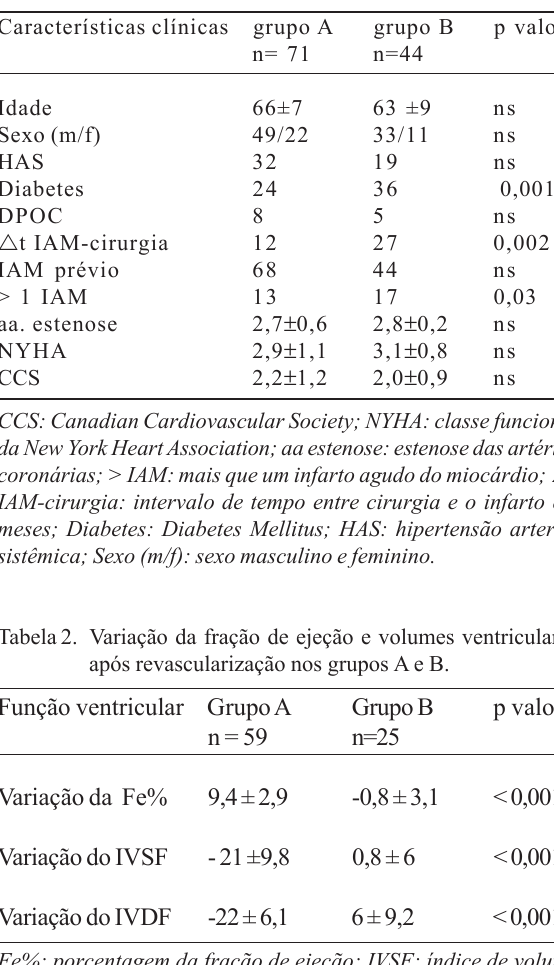
Tabela 1. Características clínicas dos pacientes.